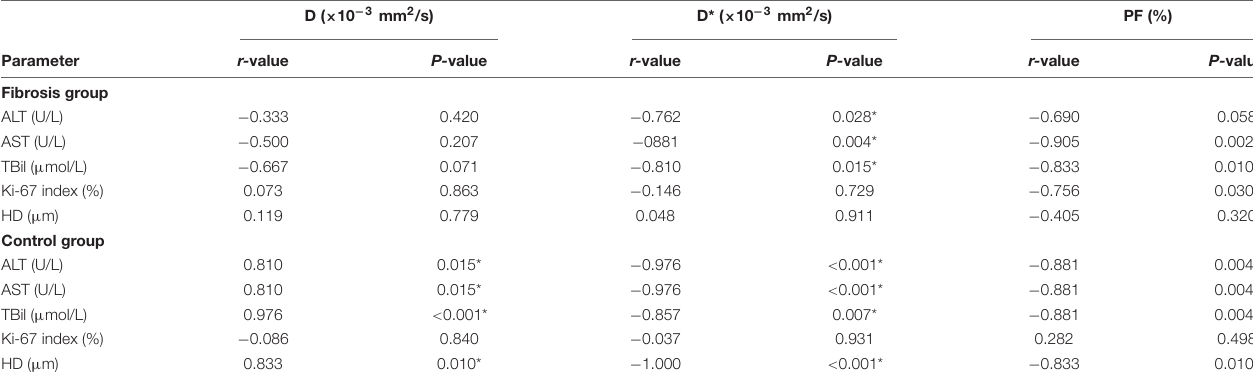
TABLE 3 | Correlation matrix for IVIM parameters and laboratory and histologic measurements in the control and fibrosis liver tissue